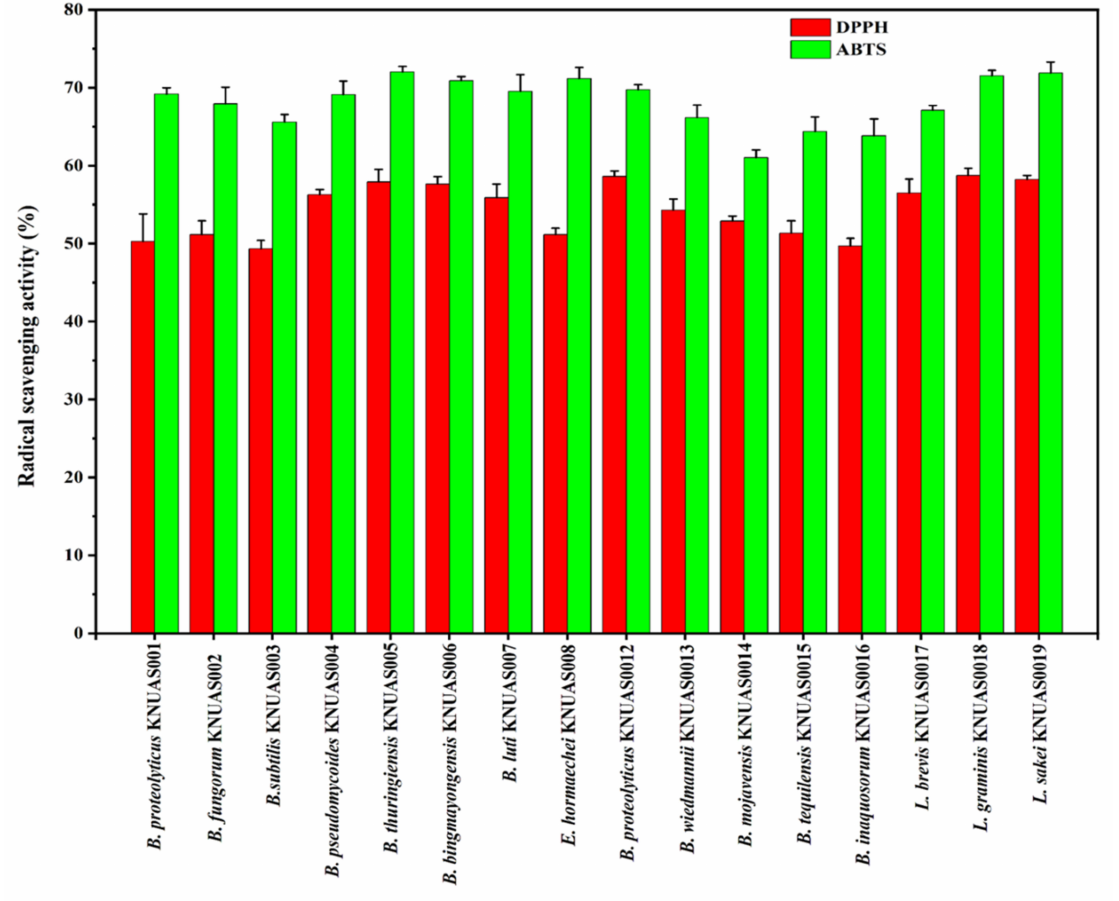
Figure 3. Antioxidant activity of cell free supernatant (CFS) of isolated bacterial strains. DPPH and ABTS radical scavenging